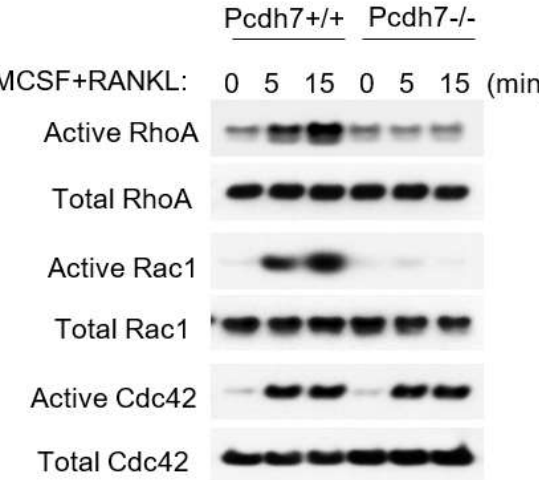
Figure 2. Pcdh7 is required for RhoA and Rac1 activation. Pre-osteoclasts were prepared from Pcdh7 +/+ and Pcdh7 −/− BMMs cultured with M-CSF (60 ng/mL) + RANKL (150 ng/mL) for a day and stimulated with M-CSF + RANKL for the indicated times. The activated forms of RhoA, Rac1, and Cdc42 were detected by a pull-down assay.